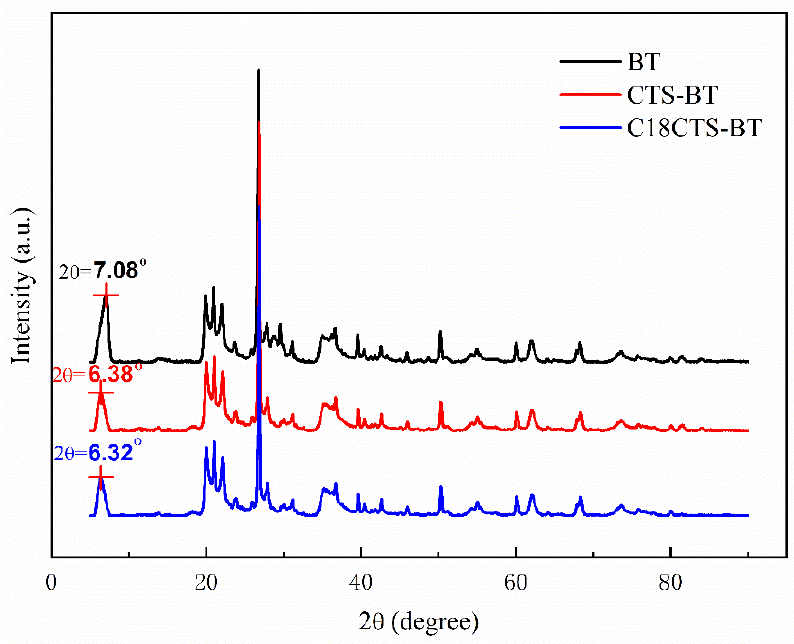
Figure 3. XRD patterns of the adsorbents.